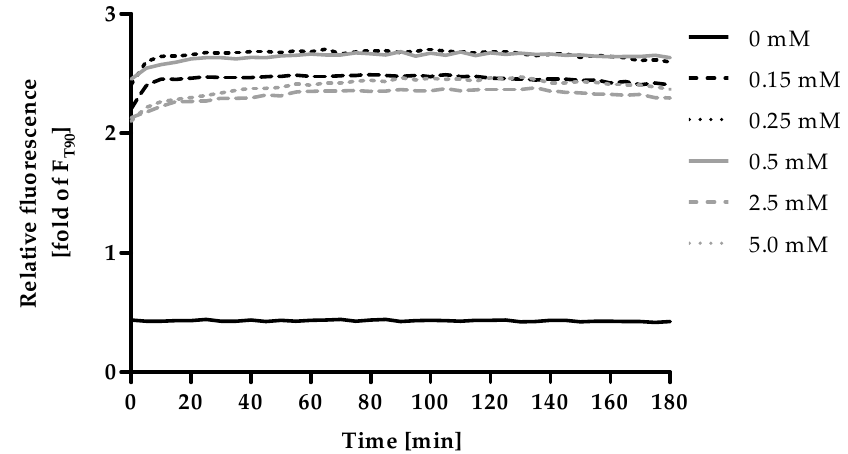
Figure 4. Kinetics of F max . The final assay procedure was performed up to the measurement of F min as described in Materials and Methods and the experiment was started by the addition of different ZnSO 4 -solutions (final concentrations as indicated). Fluorescence was measured in 5 min intervals for a total duration of 180 min. Data are shown relative to the value for F used in the final assay procedure, representing means of n = 3 independent experiments.